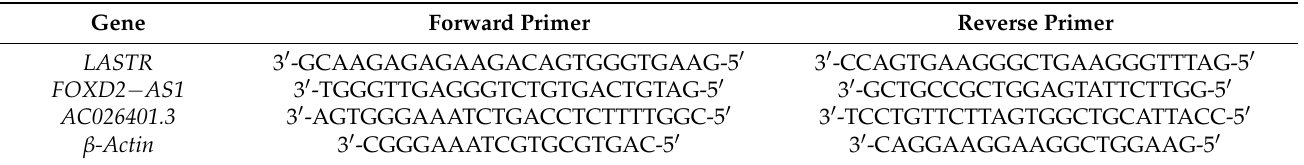
Table 1. Primers for